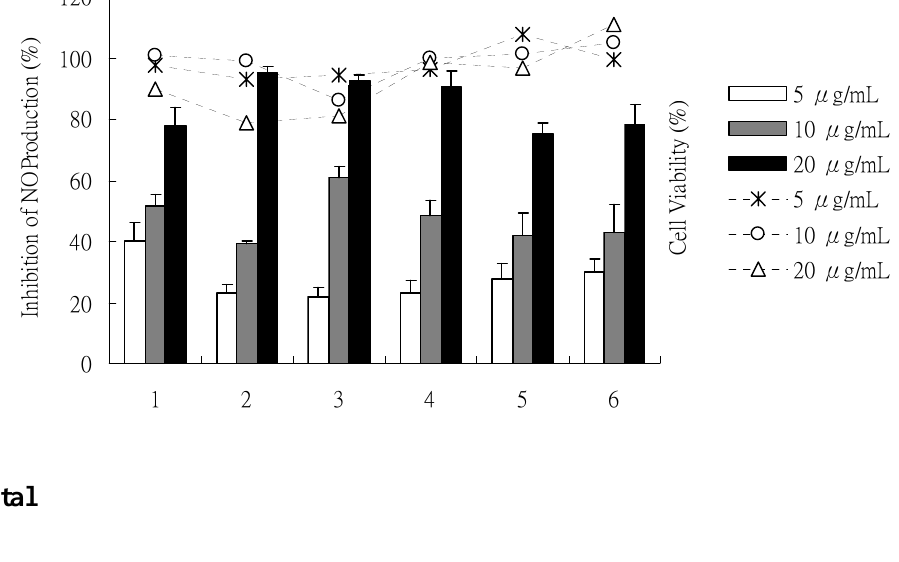
Figure 4. Effects of isolates ( 1 - 6 ) on NO synthesis in LPS stimulated RAW 264.7 cells (%) and cell viability (%) at concentrations of 5, 10, 20 μ g/mL. The bars and the lines indicate inhibition of NO production and cell viability, respectively. ( 1 : monapurfluore A, 2 : monapurfluore B, 3 : monascopyridine C, 4 : monascopyridine D, 5 : monasfluore A, 6